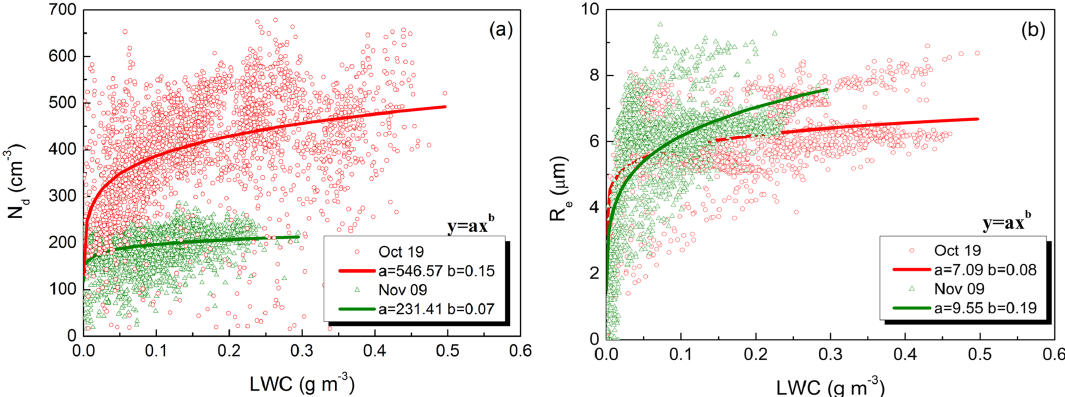
Figure 4. Correlations between (a) N d (cm − 3 ), (b) R e (µm), and LWC (gm − 3 ) for clean (green) and polluted (red) cases,